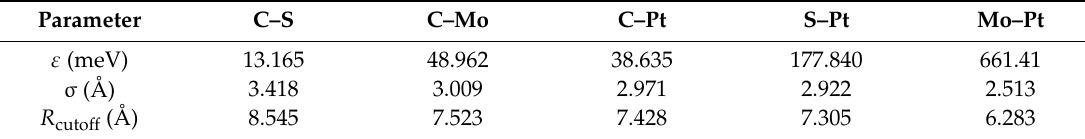
Table 2. Parameters of LJ potentials used in the simulation